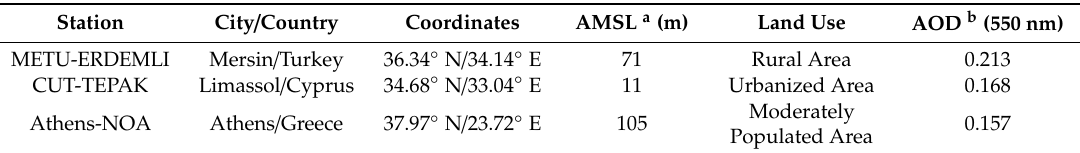
Table 1. Aerosol Robotic Network (AERONET) ground-based stations and obtained mean aerosol optical depth (AOD) for the period